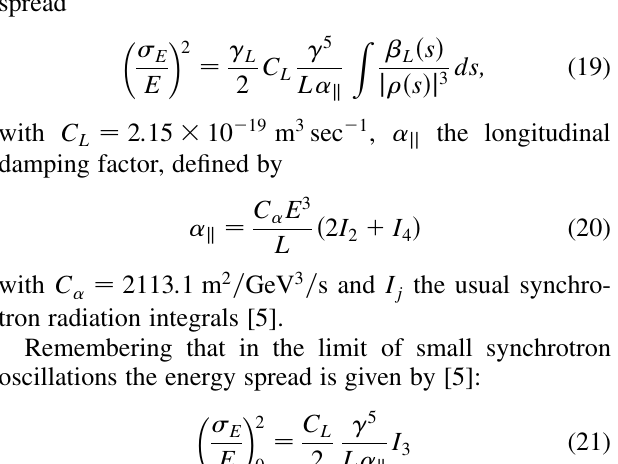
(cid:6) 3 MV . The rf , and c , as in the previous c